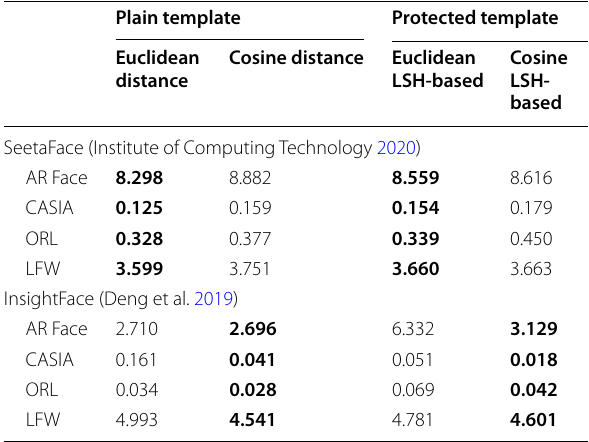
Table 4 Equal error rate (EER) of plain template and protected template